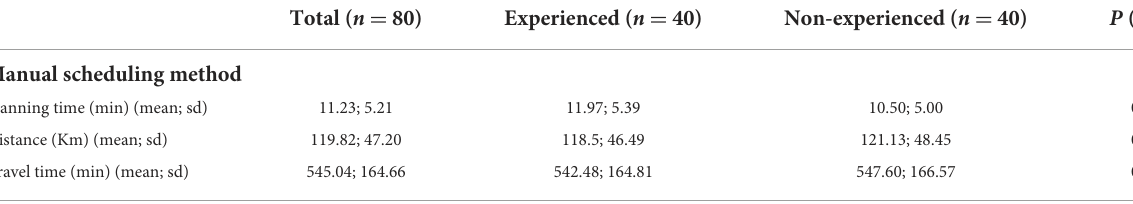
TABLE 6 Manual scheduling method: comparing groups attending to expertise. Total ( n = 80) Manual scheduling method